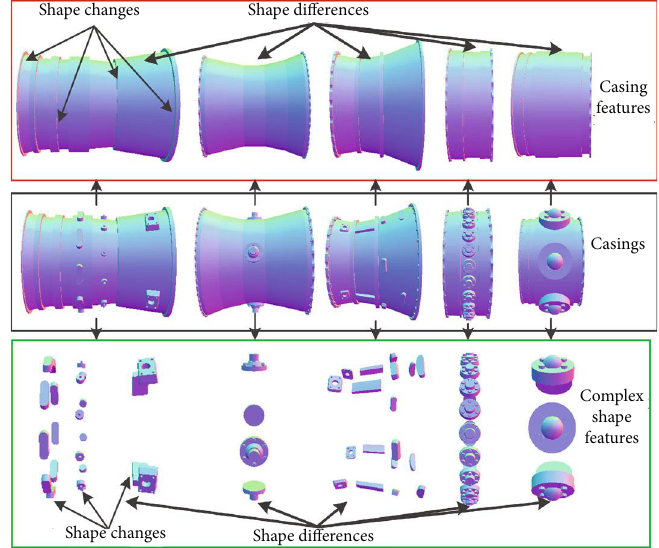
Figure 5: The shape changes and shape di ff erences of aero-engine